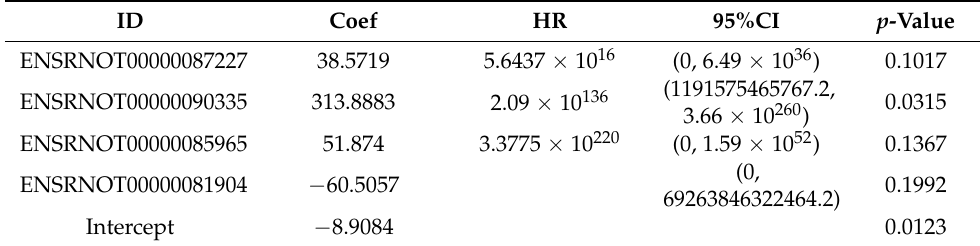
Table 2. Diagnostic model in logistic regression analysis.